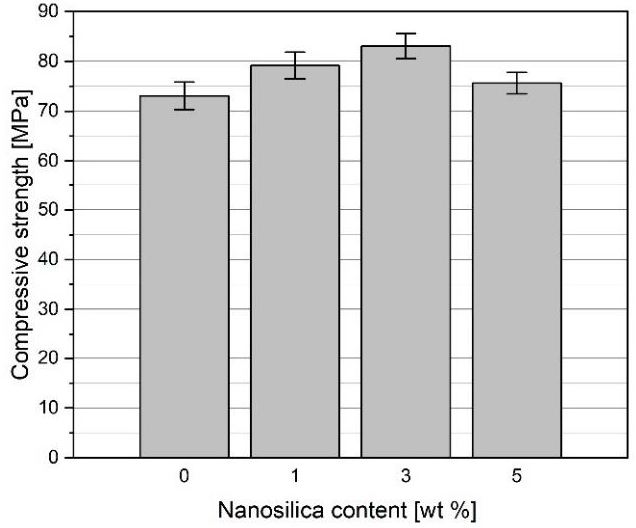
Figure 14. Compressive strength of concretes modified with NS after 28 days of curing (cured in water).